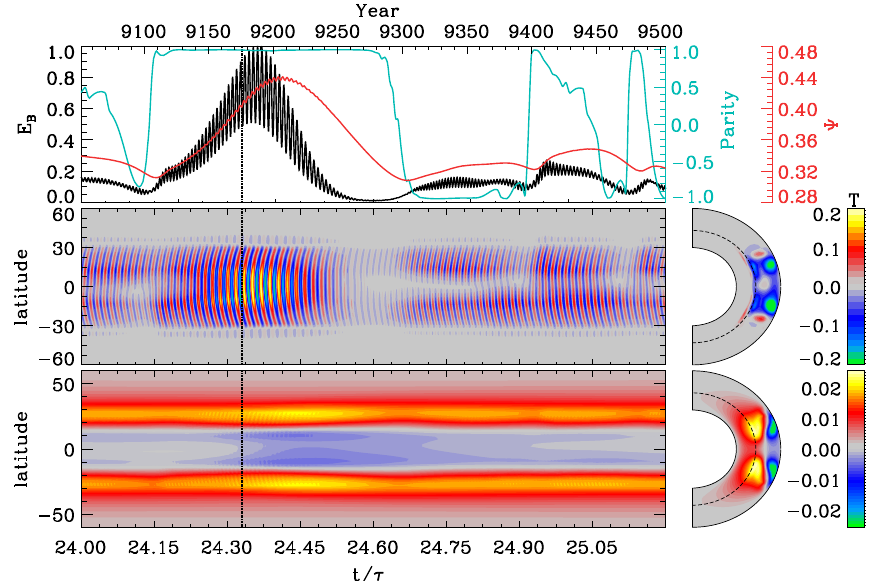
Fig. 8. Identical in format to Figure 4, but for a solution exhibiting strongly aperiodic behavior. This is solution run 4 in Table